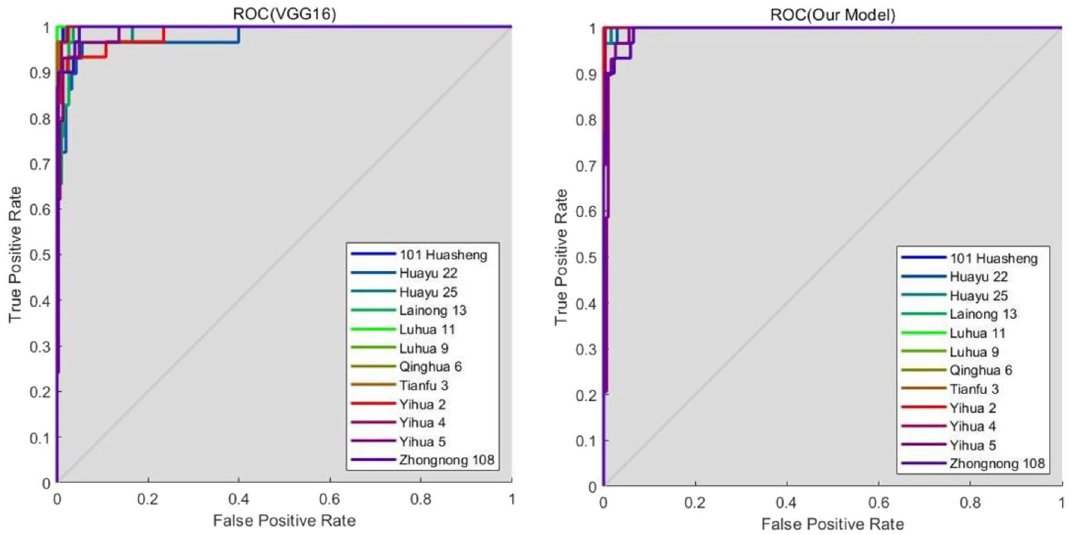
Figure 8. Model ROC curve